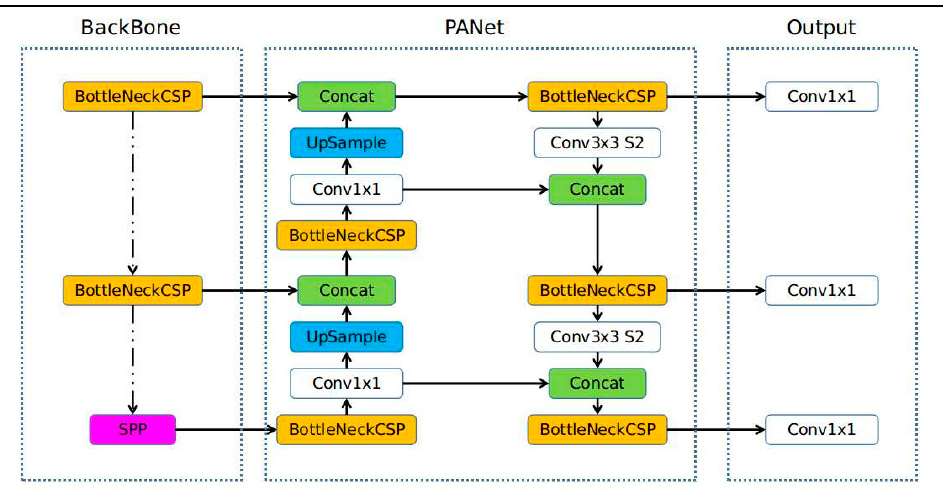
Figure 3. YOLOv5 network structure.